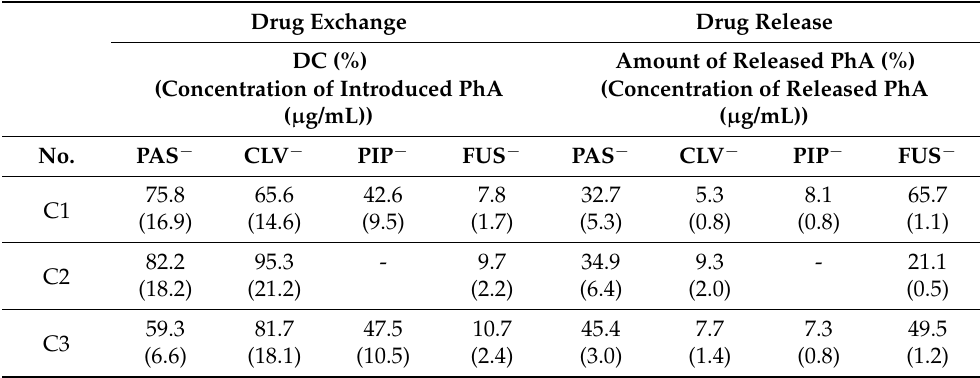
Table 2. Data for exchanged and released pharmaceutical anion (PhA) in the TMAMA-based polymers. Drug